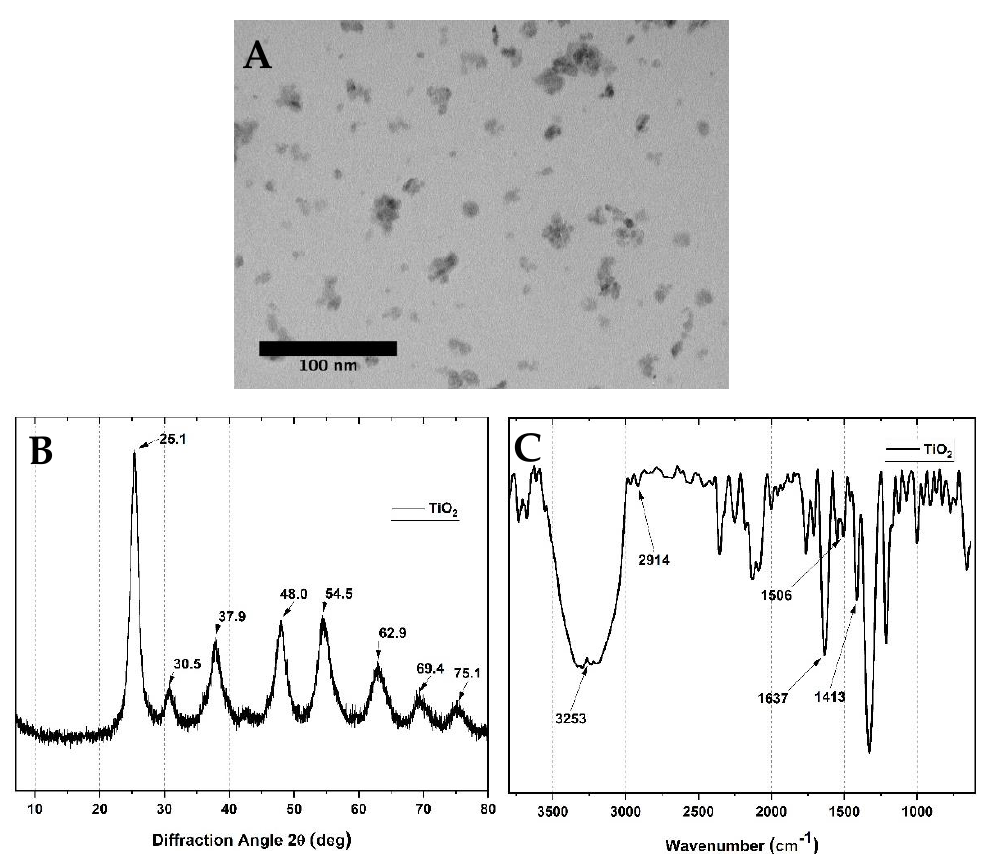
Figure 1. Characterization of TiO 2 nanoparticles by ( A ) TEM, ( B ) XRD, and ( C ) FTIR spectroscopy.